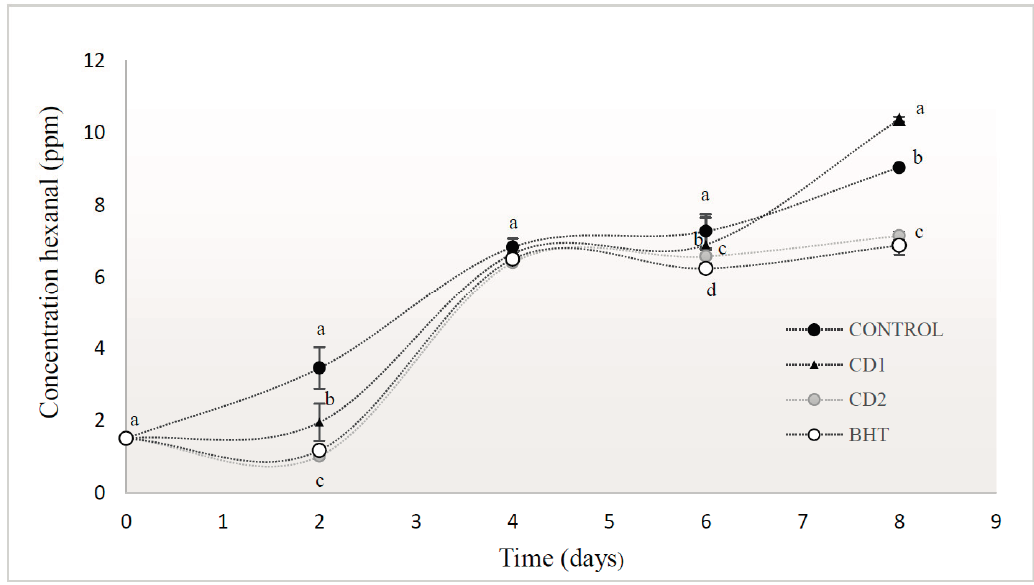
Figure 3. Hexanal in beef patties with C. decapetala extract added at 0.1% and 0.5% ( w / w ) concentration and BHT packaged in a modified atmosphere and stored at 5 °C. Results are given as mean ± standard error. Different letters in the same day (a–d) indicate significant differences between